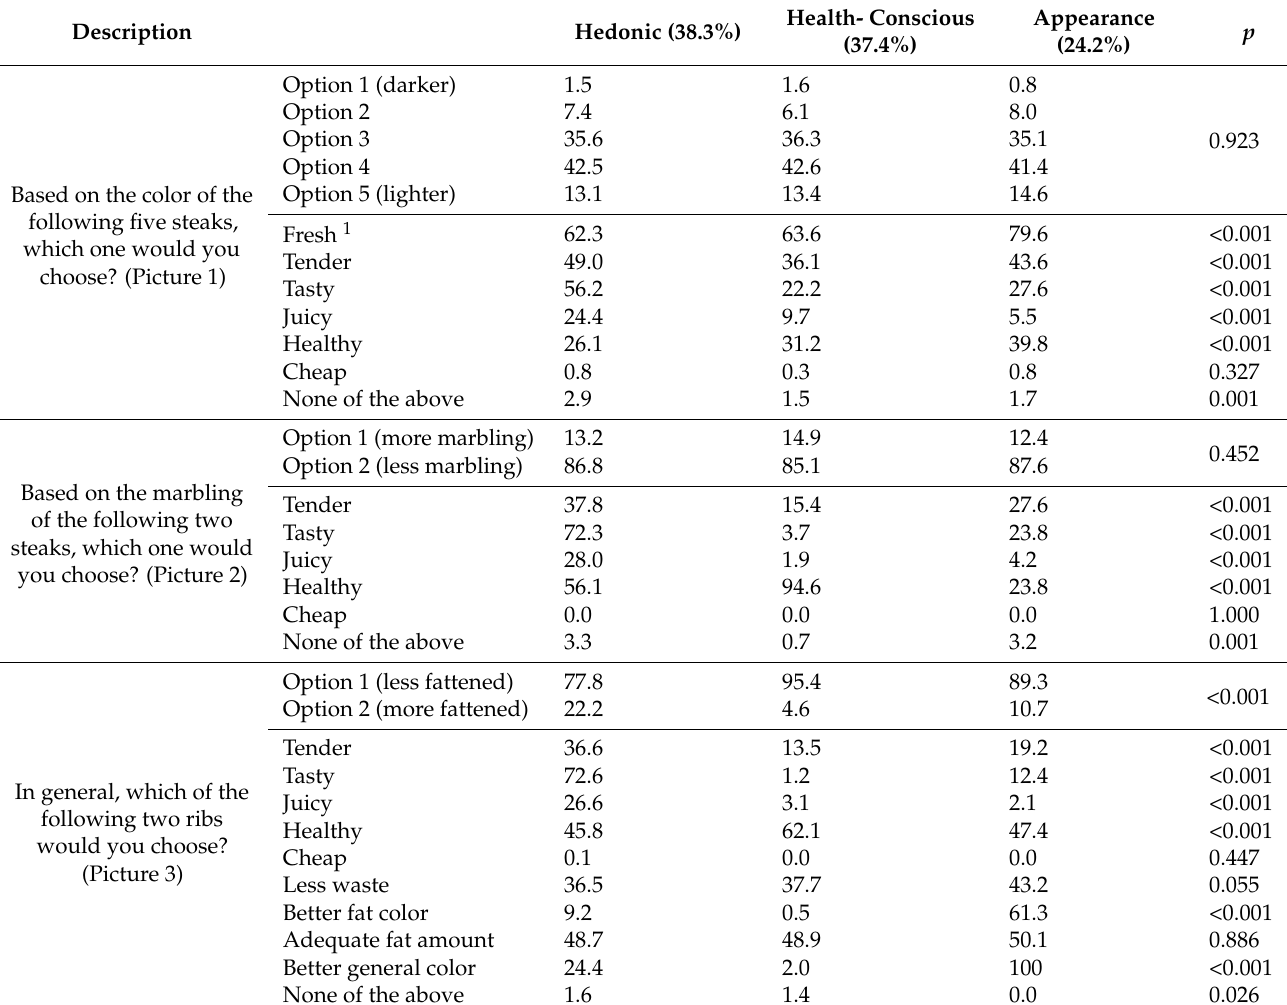
Table 8. Description of consumer profiles (clusters) according to their choice behavior. Percentages are of people who marked a criterion as used in the choice of each